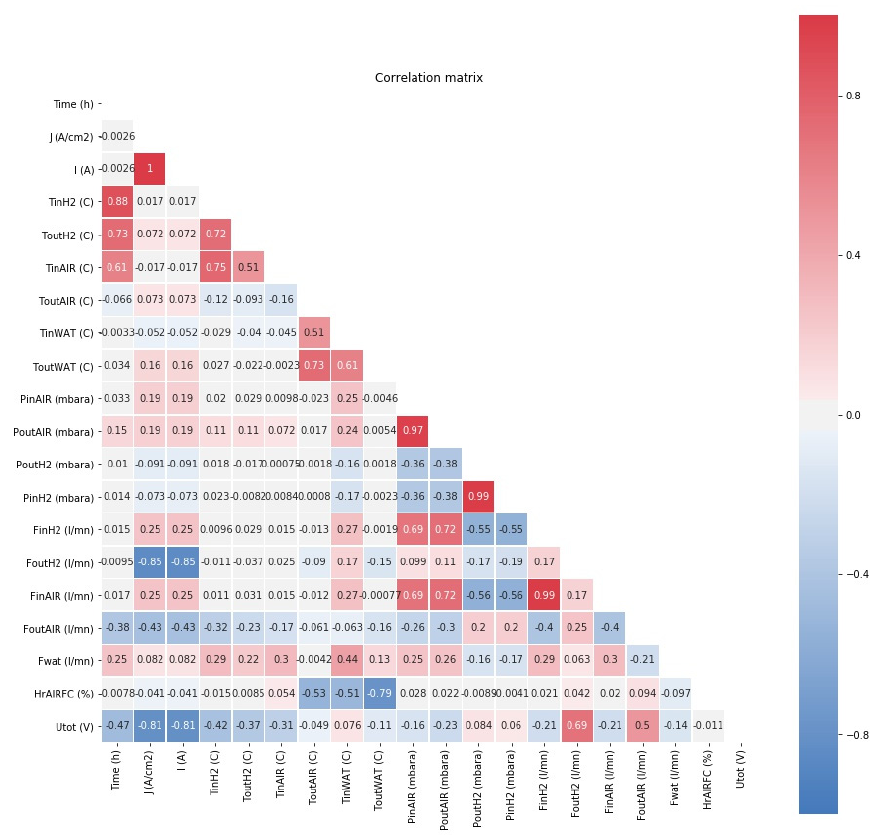
Figure 4. Fuel cell correlation matrix.